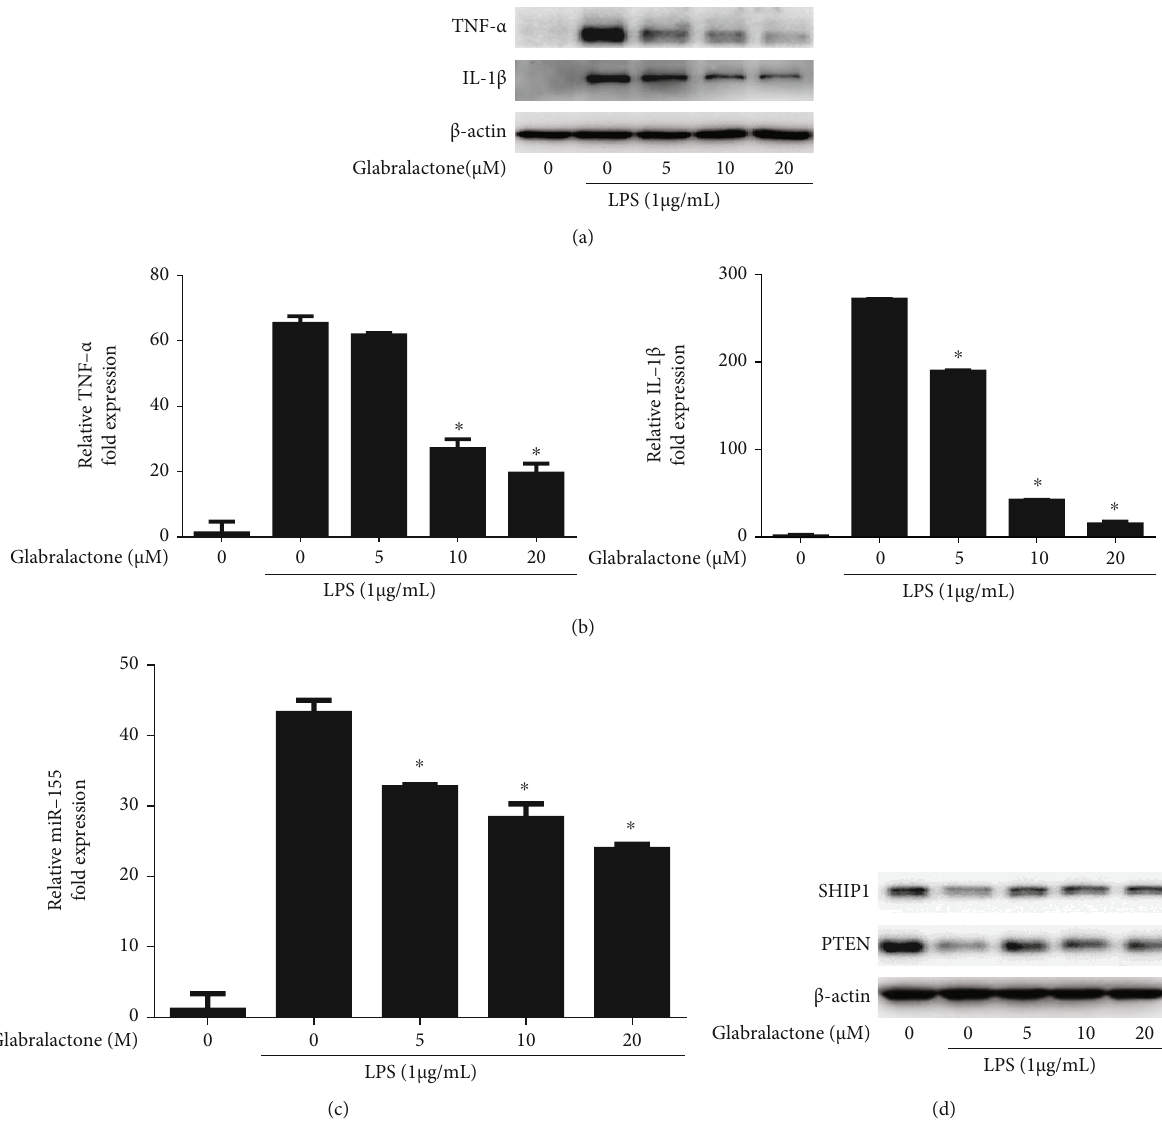
Figure 4: E ff ect of glabralactone on LPS-induced proin fl ammatory cytokine and miR-155 expressions. The proteins (a) and mRNA (b) levels of TNF- α and IL-1 β were determined by Western blotting and qRT-PCR, respectively. Cells were stimulated with LPS (1 μ g/mL) in the presence of glabralactone for 4 h and was further analyzed as described in Materials and Methods. Data are representative of three separate experiments. β -Actin was used as an internal standard. (c) E ff ect of glabralactone on the expression of miR-155 in LPS- stimulated RAW264.7 cells. The cells were stimulated with LPS in the presence of glabralactone for 8 h. The expression of miRNA-155 was determined by qRT-PCR as described in Materials and Methods. The values are expressed as the means ± SD . (b, c) ∗ p < 0 : 05 was considered statistically signi fi cant. (d) E ff ect of glabralactone on the expression of SHIP1 and PTEN in macrophage cells. Cells were treated with glabralactone for 30 min and then stimulated with LPS for 30 min. Proteins were analyzed by Western blotting. Data are representative of three separate experiments. β -Actin was used as an internal standard. Glabralactone was dissolved in 100% DMSO, and the fi nal concentration of DMSO was adjusted to